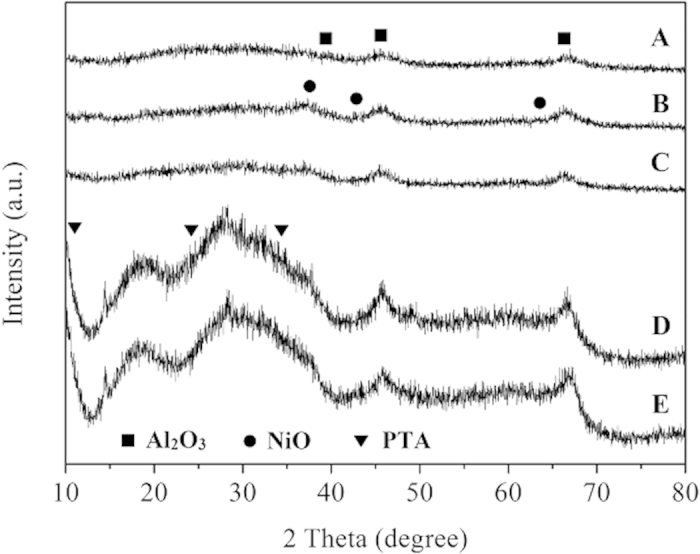
XRD patterns of (A) synthetic Al2O3 support, (B) synthetic Ni/Al2O3 catalyst and (C) synthetic Ni-PTA/Al2O3 catalyst, (D) Ni-PTA/Al2O3 grain, (E) Ni-PTA/Al2O3 powder.